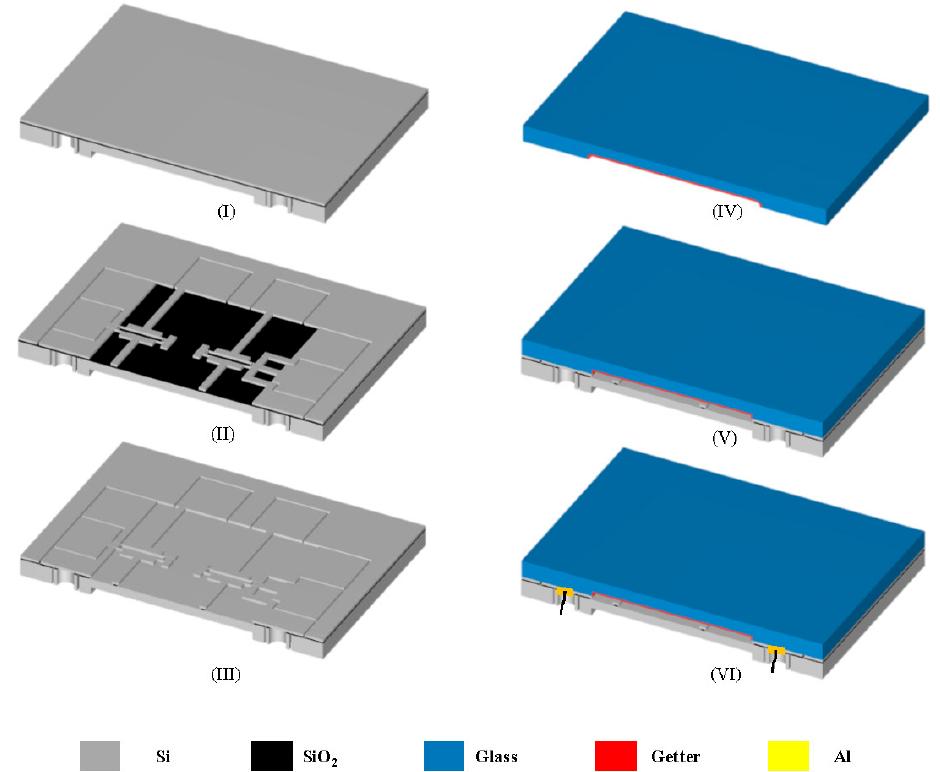
Figure 2. The fabrication flow chart of the proposed resonant pressure micro-sensor includes key steps of ( I ) formation of the pressure-sensitive membrane and through-silicon vias by DRIE; ( II ) patterning of the resonator by DRIE; ( III ) release of the resonator using an HF buffer; ( IV ) deposition of getter material on glass covers, ( V ) silicon-to-glass anodic bonding; ( VI ) formation of electrical